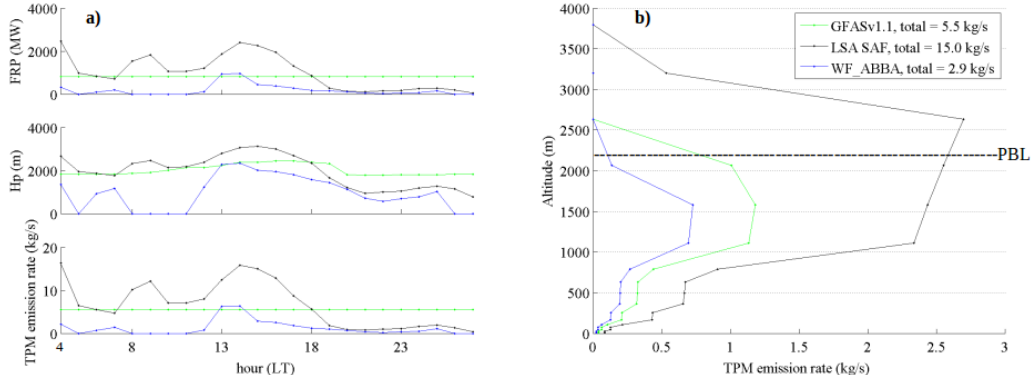
Figure 4. (a) Temporal variation of FRP, plume injection height (Hp) and TPM emission rate for a strong emitting fire pixel in the model grid belonging to the Antalya fire on 1 August 2008. (b) Vertical distribution of PM 2 . 5 emission rate over the same pixel at 15:00LT of the same day. The black-dashed line defines the